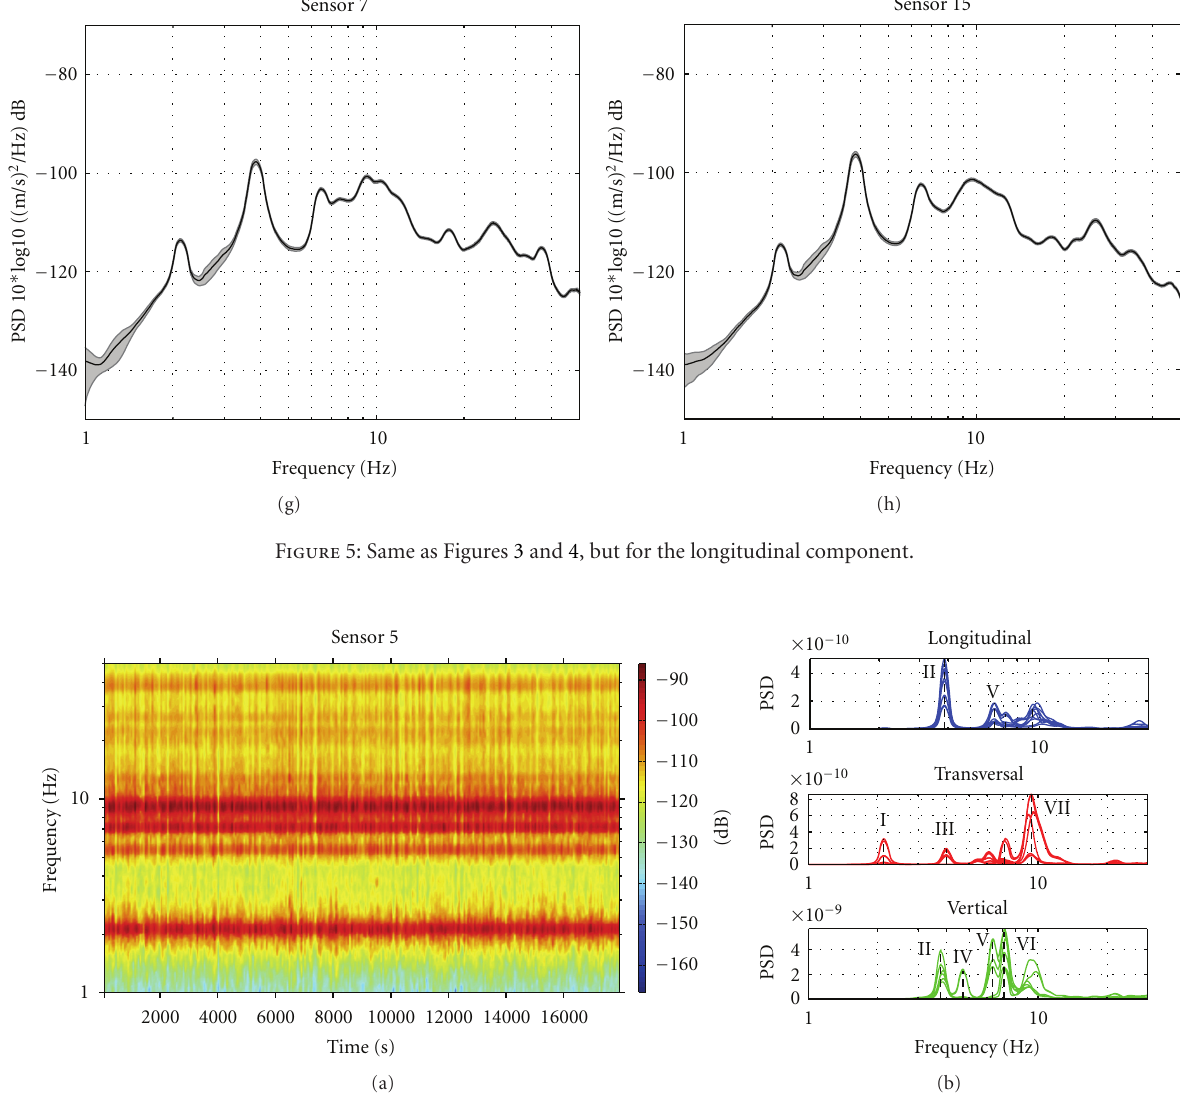
Figure 6: (a) Example for the spectrograms (sensor 5, transversal component) over the 5-hour time window (10:00–15:00 UTC). Please compare with the PSD estimate at sensor 5 shown in Figure 4. (b) PSD estimates of sensors on both sides along the bridge deck plotted together for each component on a log-linear scale. Black dashed lines: frequencies of the vibration modes considered for deriving the modal shapes of the bridge. The modes are annotated by their roman number, as given in Table